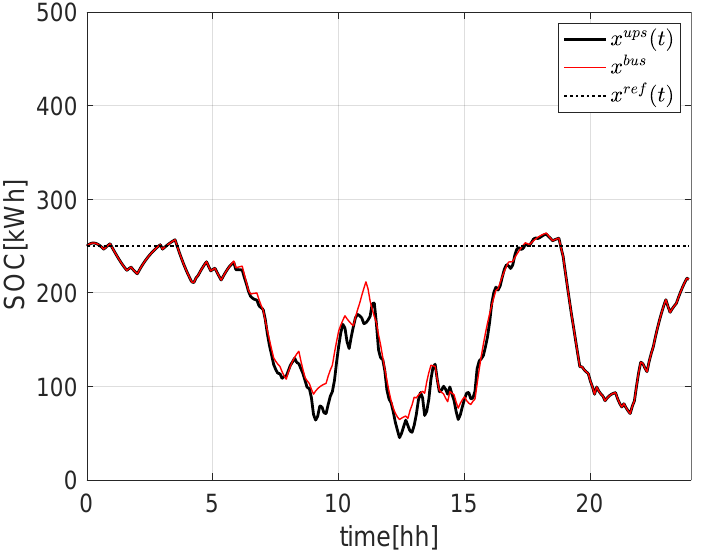
Figure 11. ESS SOC evolution in case of uncertainties for BUS (red) and UPS (solid black) configurations. It is important to note that the uncertainties on ˆ u ev ( t ) do not affect either p ( t ) or x ( t ) . This is due to the fact that ˆ u ev ( t ) is not directly applied to the charging PEV, but the latter is controlled by the control variable u ev ( t ) . This means that any uncertainties on ˆ u ev ( t ) directly reflect on the end-user charging power rather than on the power at the POC or the ESS